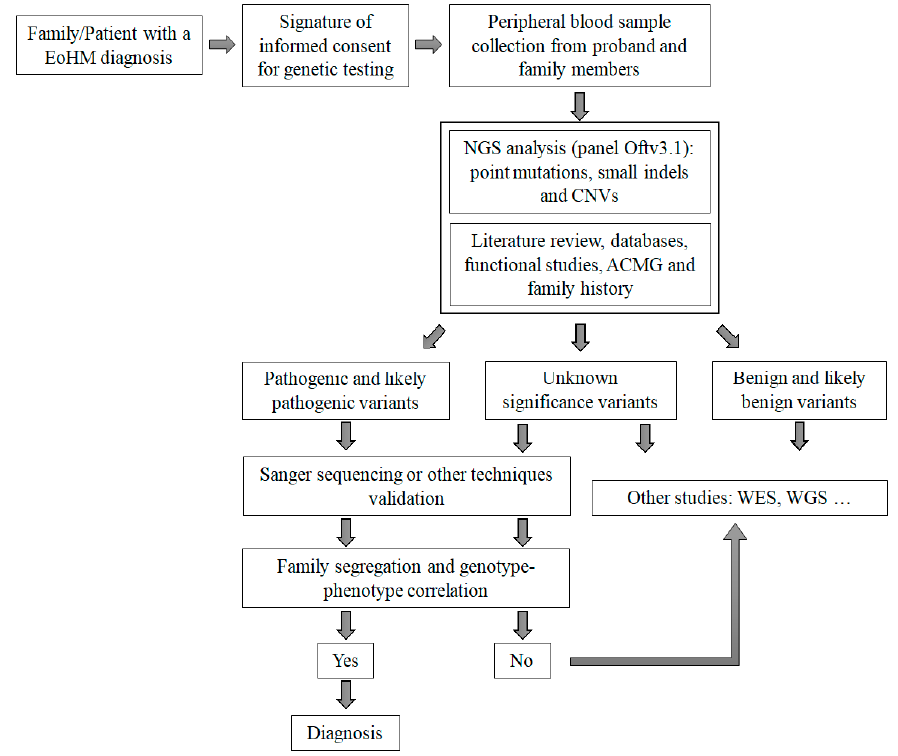
Figure 7. Diagnostic algorithm for early-onset high myopia. EoHM, early-onset high myopia; CNVs, copy number variants; ACMG, American College of Medical Genetics; NGS, next-generation sequencing; WES, whole exome sequencing; WGS, whole genome sequencing.